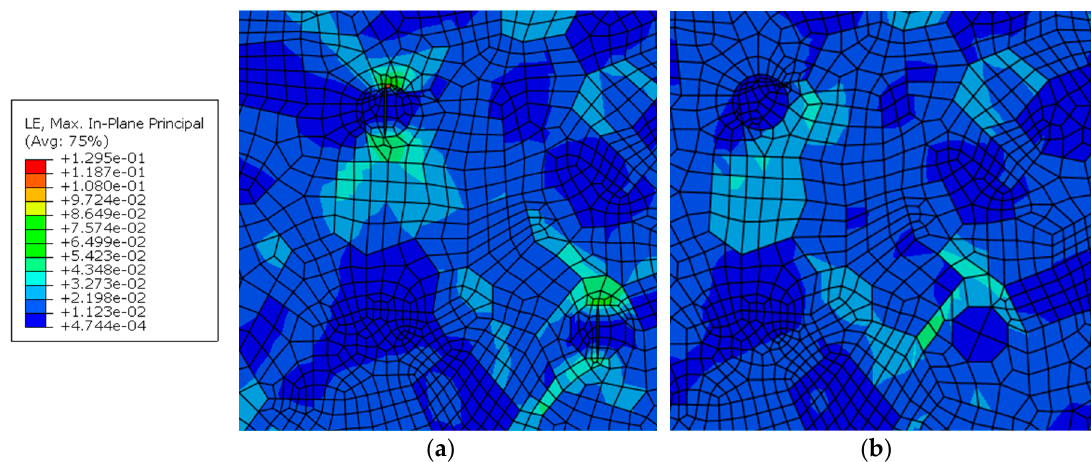
Figure 19. Distribution of von Mises equivalent stress in the WNZ of including ( a ) cracked particles and ( b ) uncracked particles, MPa.